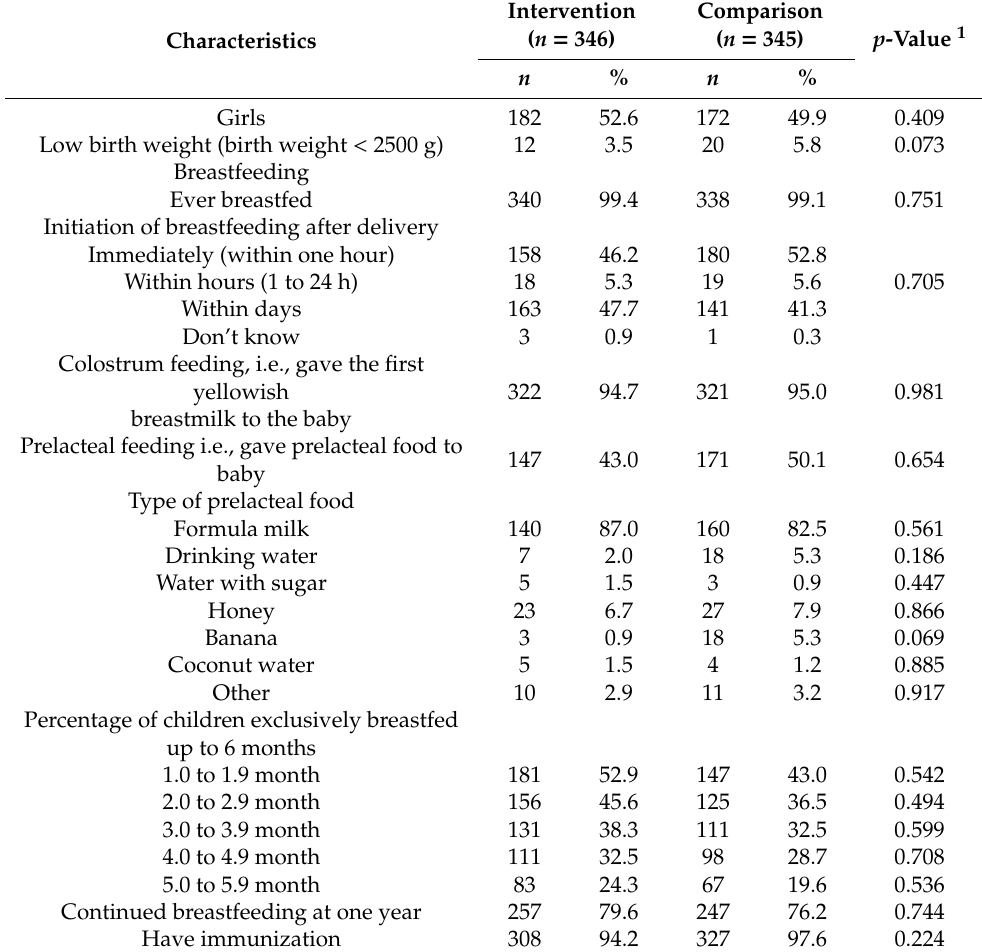
Table 4. Child characteristics and breastfeeding practices by treatment group.